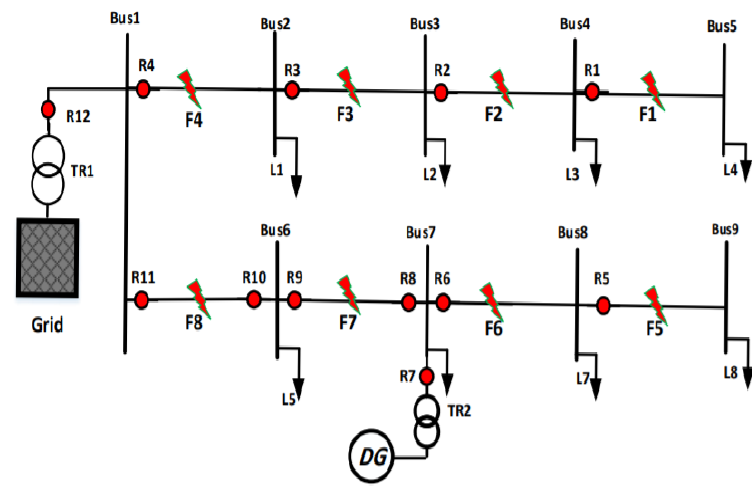
Figure 8. The IEEE 9-Bus MG system.